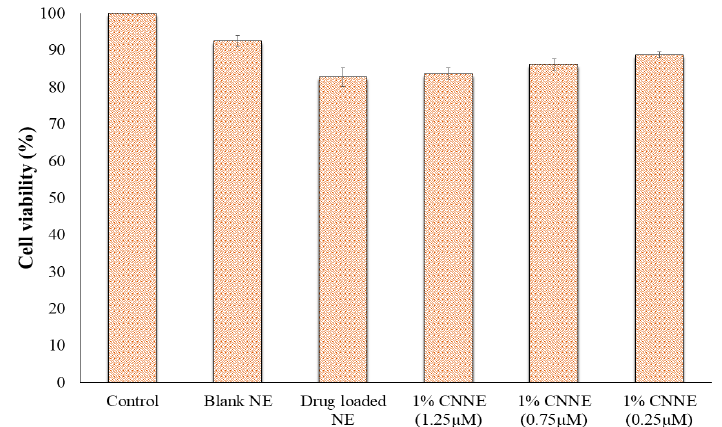
Figure 10. Cell viability analysis on embryonic fibroblast (NIH-3T3) cells upon treatment of blank NE, drug-loaded NE and different concentrations of CNNE (1%) at 24 h. The cell viability was determined by in vitro cytotoxicity assay. The control consisted of cells treated with 0.1% dimethyl sulfoxide (vehicle control representing 100% cell viability). Data are expressed as mean ± SD ( n = 3). Pharmaceutics 2020 , 12 , x FOR PEER REVIEW